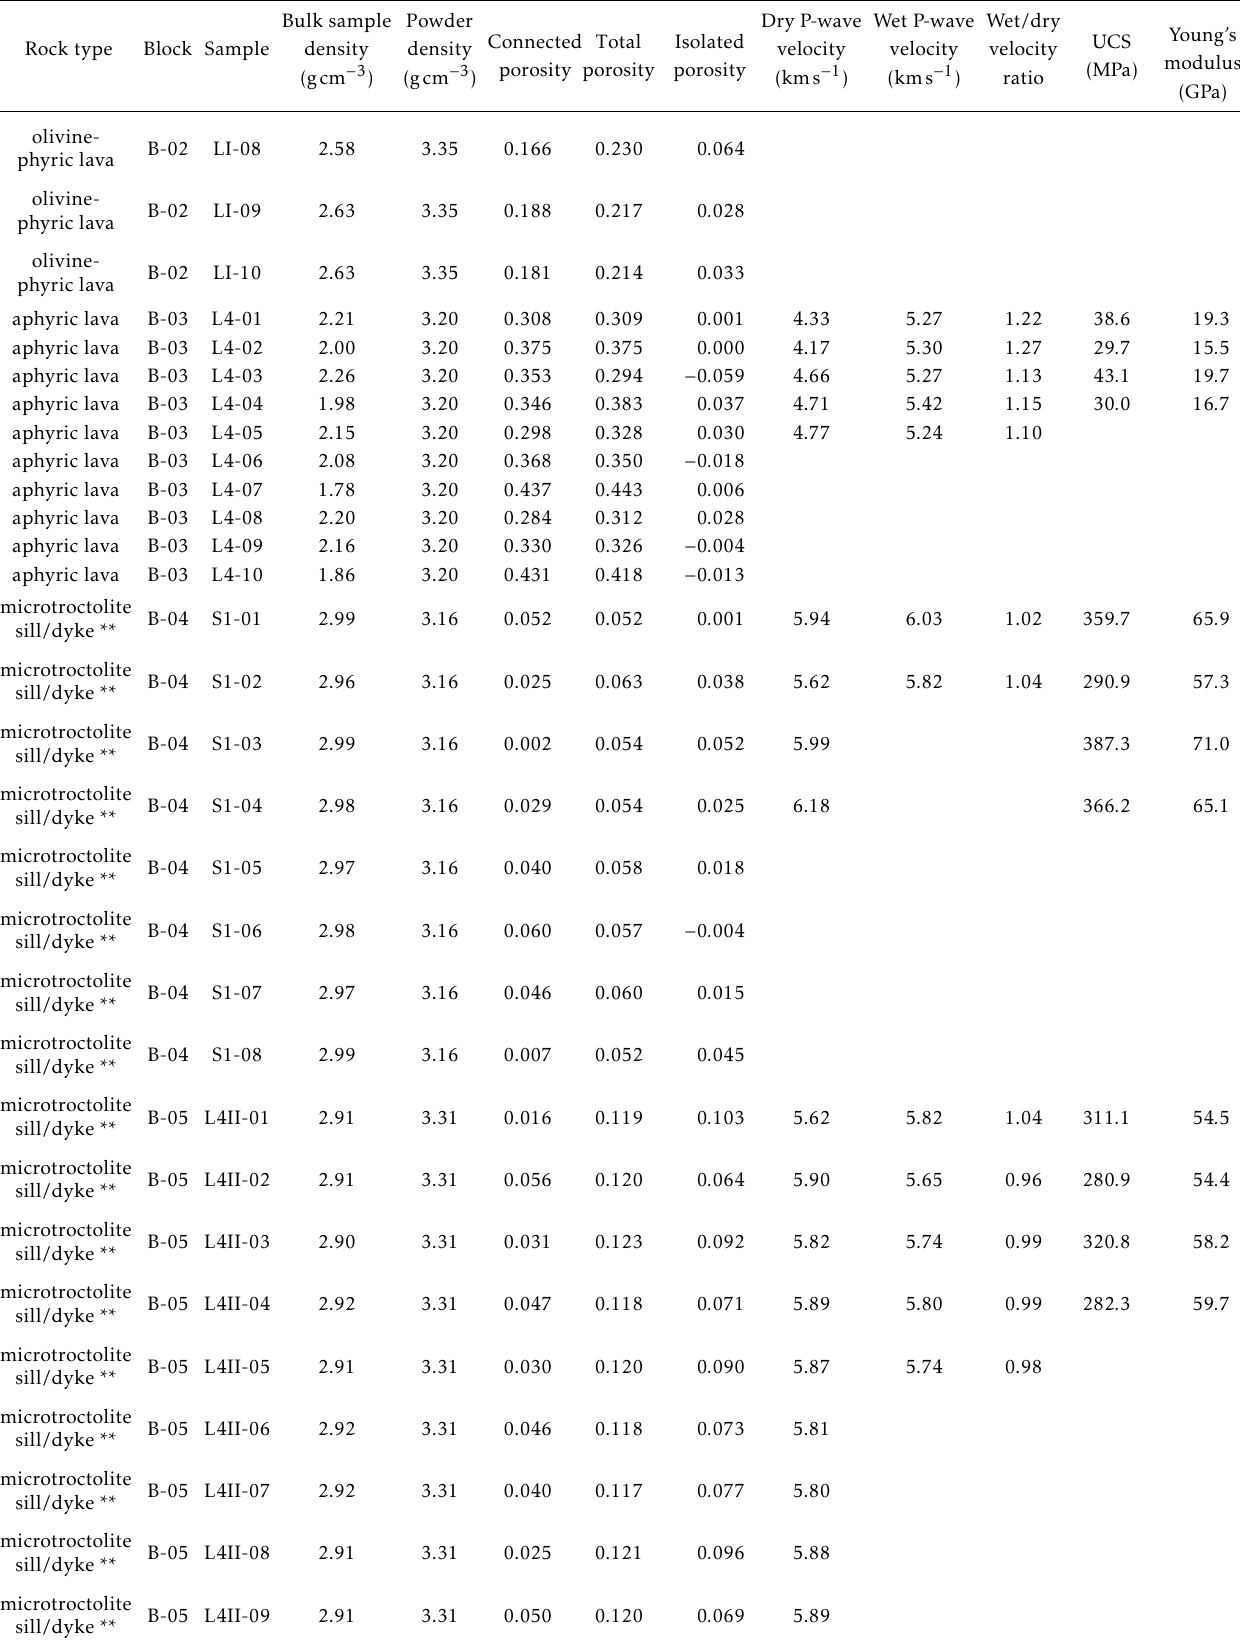
Table A1 [cont.]: Summary of the rock physical property measurements for the samples collected from Piton de la Fournaise (France) for this study. UCS – uniaxial compressive strength. **Presence of chlorite partially replacing olivine and glass. [Continued next